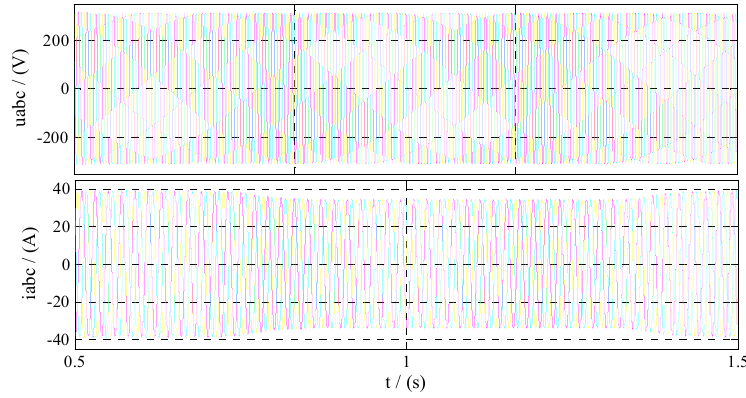
Figure A1. VSG structure in this paper.